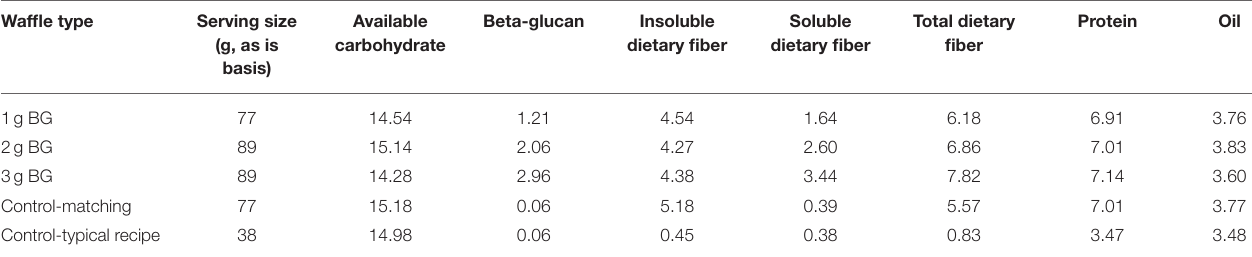
TABLE 1 | Nutrient composition of waffle treatments, based on a single